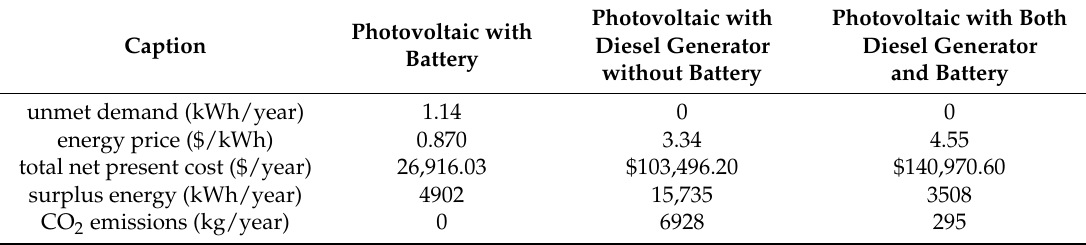
Table 5. Comparison between the operation of the three scenario hybrid energy systems—PV with Battery, PV with diesel generator and PV with both diesel generator and battery. Photovoltaic Caption